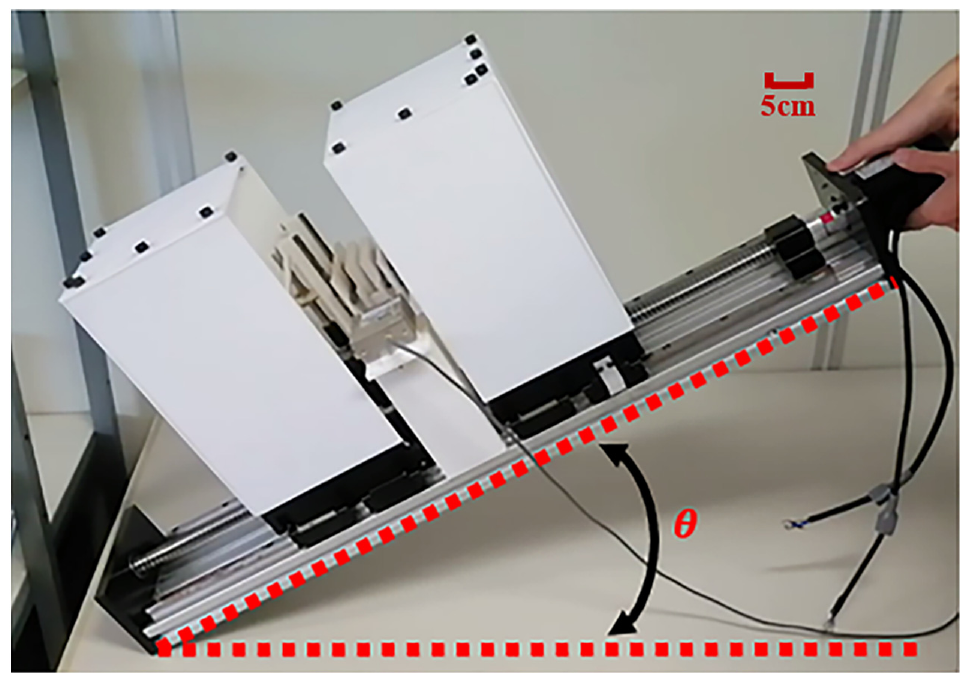
Figure 7. Schematic diagram of the SP inclined at a certain angle ( 𝜃 ).